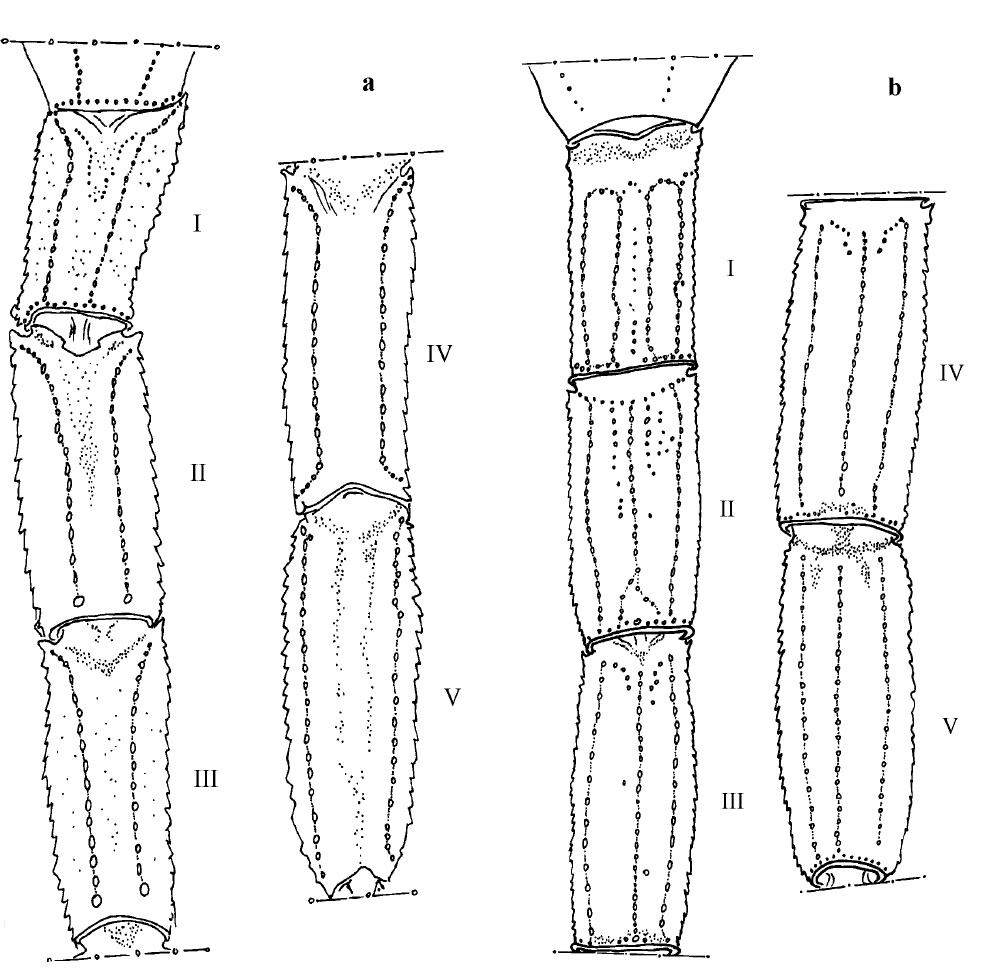
Figure 7 . Tityus gonzalespongai n. sp. Female. Caudal segments I-V. a. Dorsal view. b. Ventral